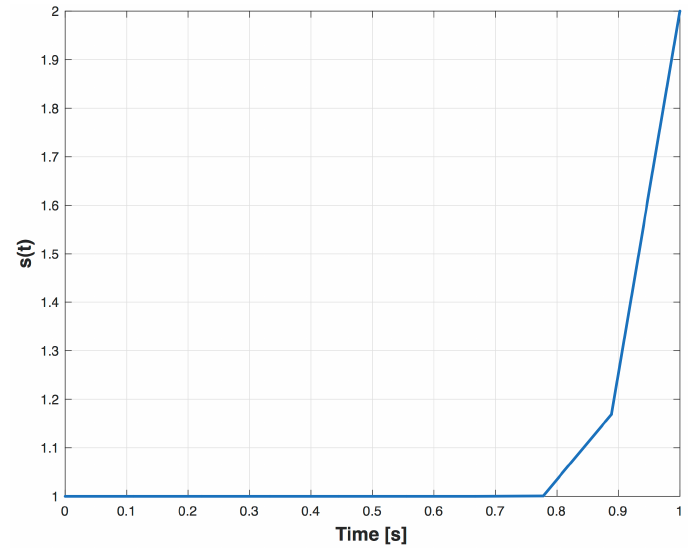
Figure 8. Trend of s ( t ) within two instants of the PVT computation.